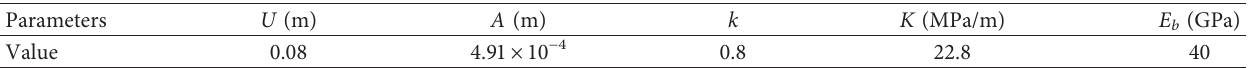
Table 2: Calculation parameter values of the